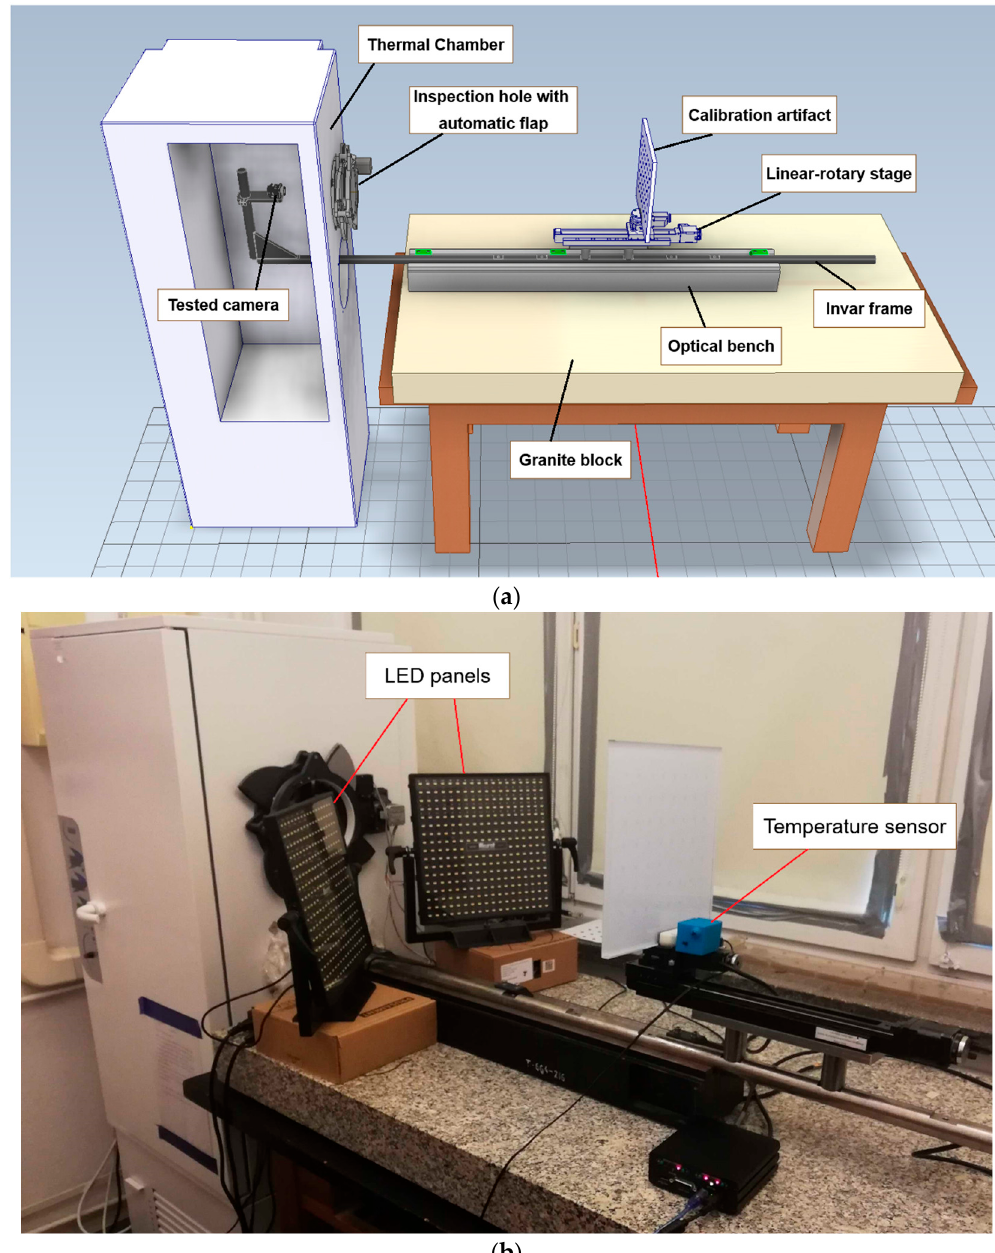
Figure 2. Designed test stand. ( a ) The schematic view of the test stand with the thermal chamber and the invar frame. The invar frame is clamped onto an optical bench, which is stationed on a granite block. A linear–rotary table is mounted on the invar frame, which can control the position of the calibration artifact along the optical axis. The thermal chamber has an opening for the invar frame to pass through and another opening for inspection purposes, which has a controllable automatic flap mounted. ( b ) Photo of the actual test stand stored in the laboratory. Here, the LED panels and the temperature sensor to record the room temperature are visible.